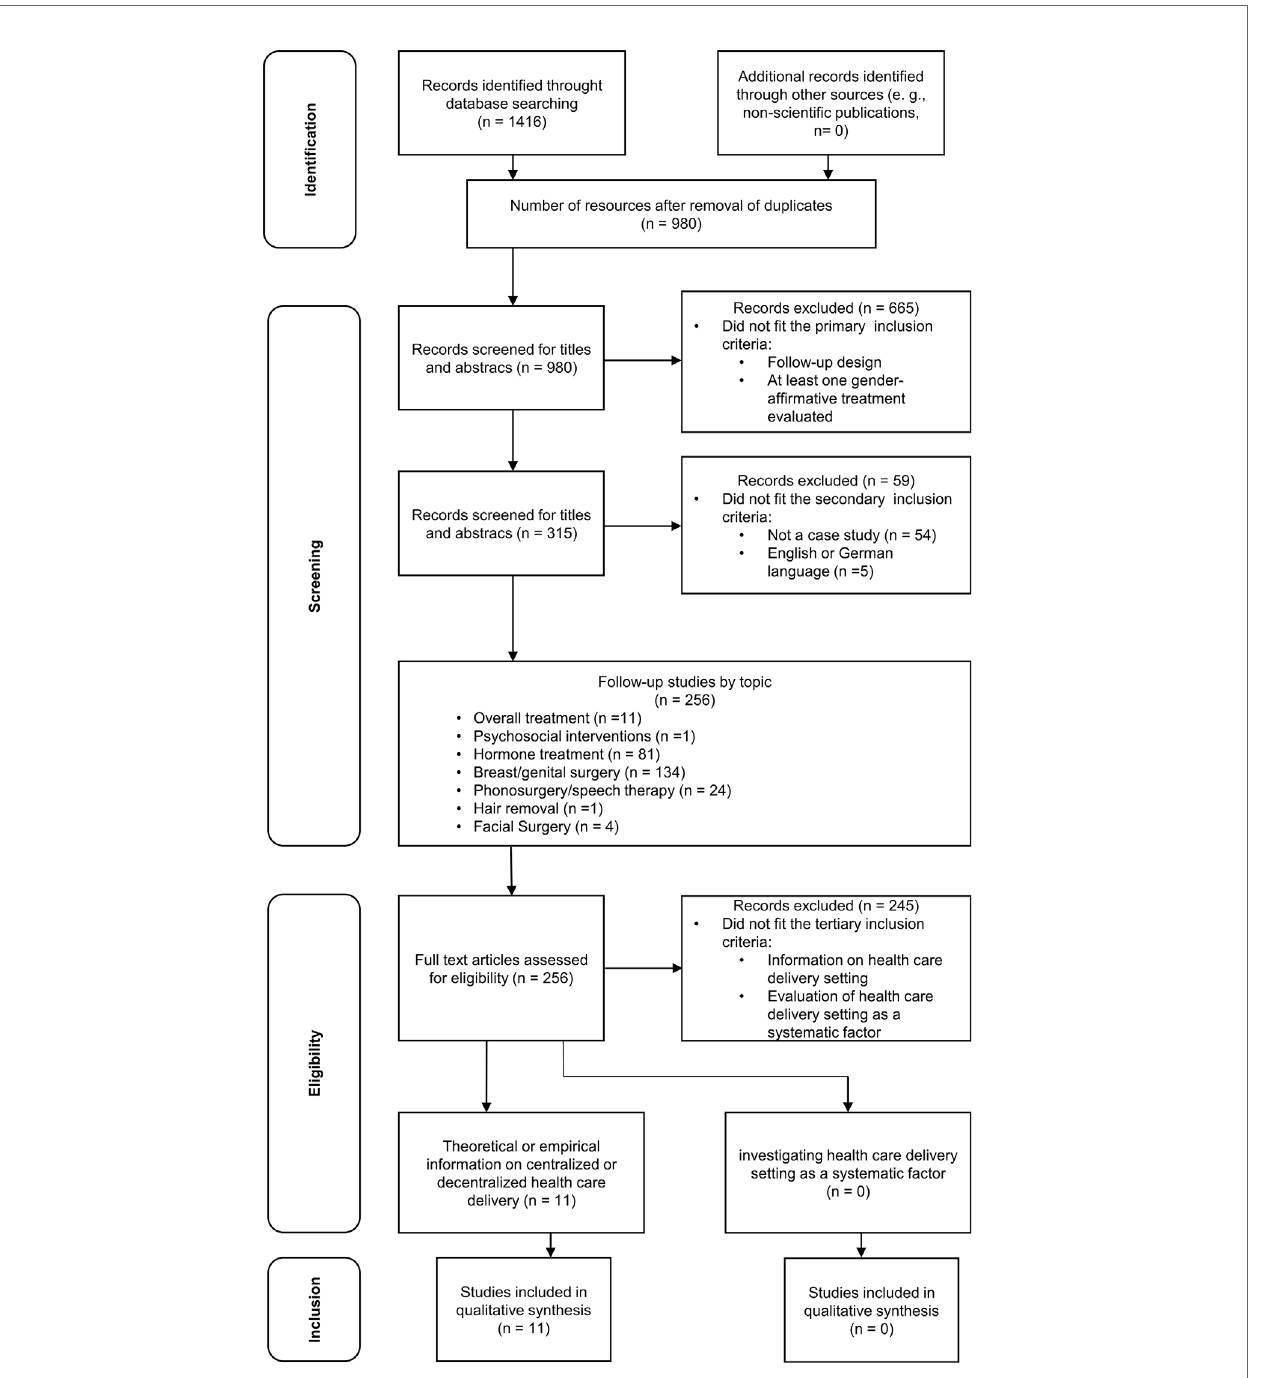
FIGURE 2 | PRISMA